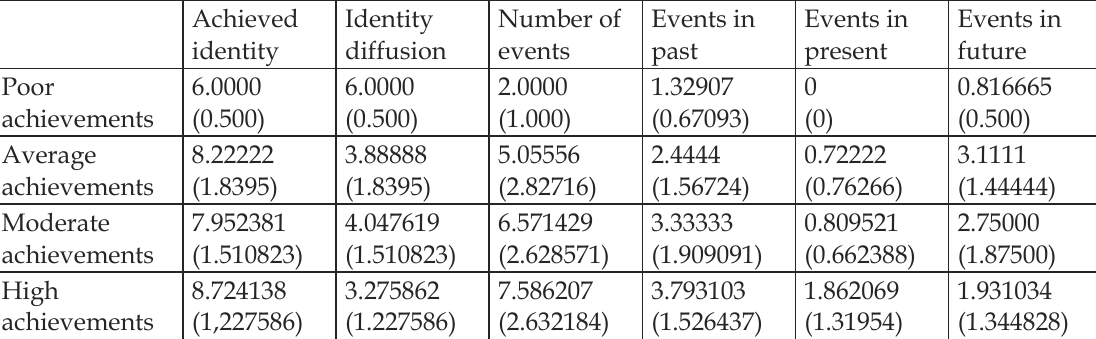
Tab.2. Descriptive rates of samples of achievements from causometric parame- ters of psychological time